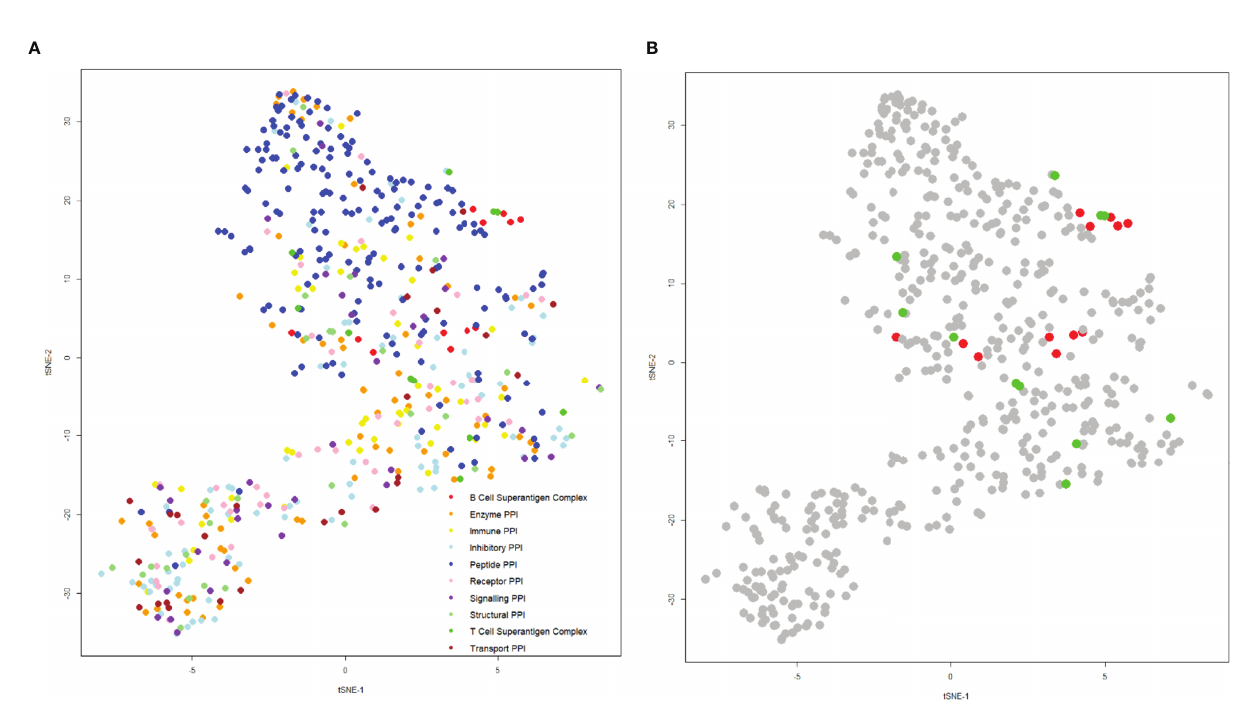
FIGURE 9 | t-SNE plot of protein-protein interactions highlighting superantigen-antibody complexes. The position of each complex was determined using the following parameters: “ Buried Surface Area (A 2 ) ” , “ Buried Surface Area Hydrophobicity (A 2 ) ” , “ Number of Interface Residues ” , “ H-Bonds ” , “ Salt Bridges ” , Category ” , “ Total Positive Charge at Interface (A 2 ) ” , “ Total Negative Charge at Interface (A 2 ) ” with a perplexity of 30. (A) Distribution of general protein-protein interactions categorized by function (T-cell superantigen complex, B-cell superantigen complex, enzyme PPI, immune PPI, inhibitory PPI, peptide PPI, receptor PPI, signaling PPI, structural PPI, toxin- antitoxin PPI and transport PPI). (B) The same plot as (A) , but coloured for T-cell superantigen complexes (green) and B-cell superantigen complexes